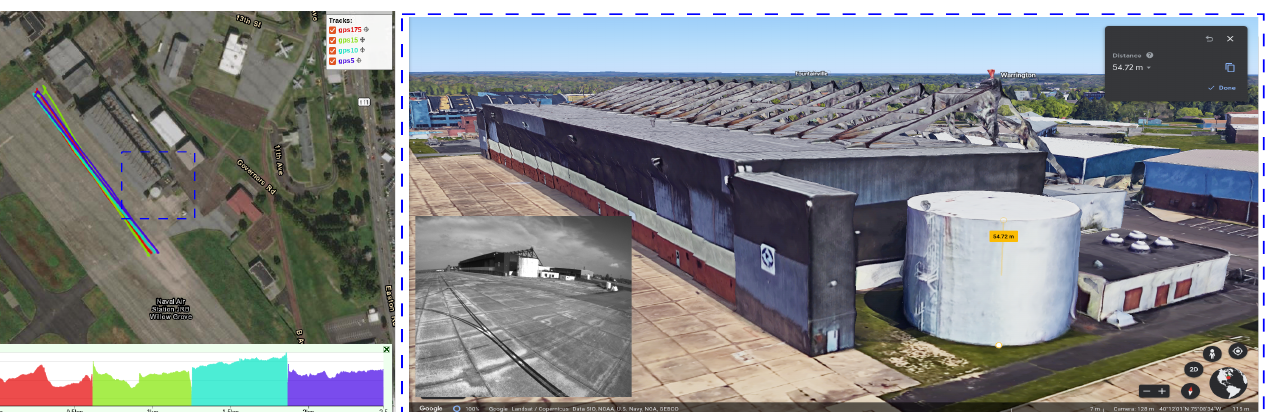
Figure 1. An example for the on-map GPS readings of the large-scale environment of the Fast Flight dataset [11] sequences: gps175, gps15, gps10, and gps5. The sequence number denotes the maximum flight velocity of each sequence: 17.5, 15, 10, and 5 (m/s), respectively. The color bar (bottom) denotes the map scale in (km) on the x axis and the altitude of each sequence in (m) on the y axis. In the blue dotted box: Comparing the maximum MAV’s altitude at instance before the descent stage to the height of an aircraft hangar. The estimated airport asset height is 54.72 (m), corresponding to the maximum MAV altitude. Images are courtesy of Google